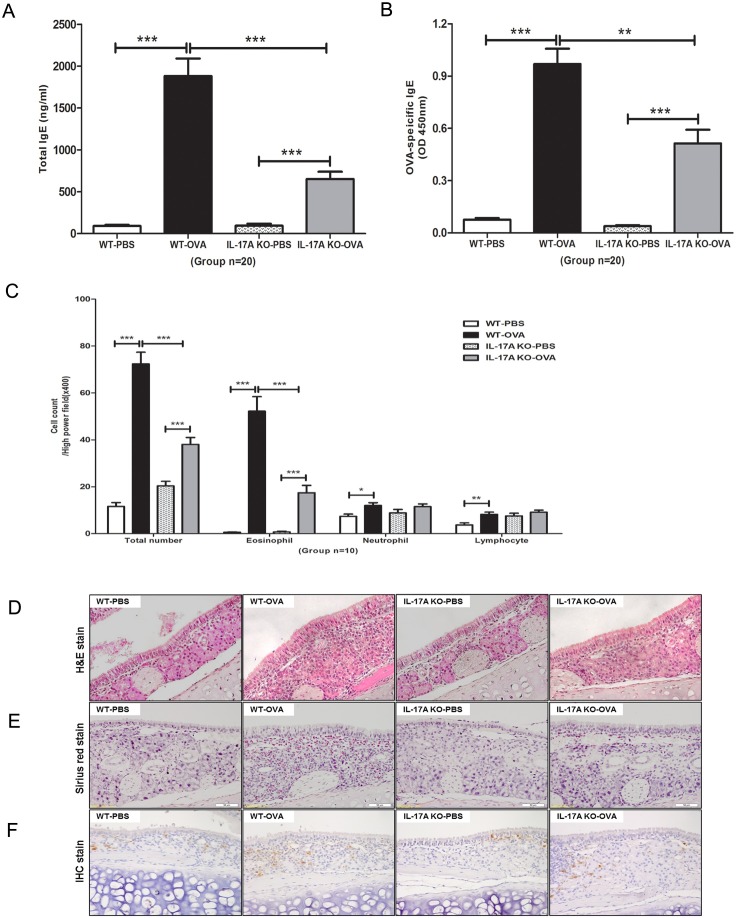
Comparison of serum immunoglobulin E (IgE) levels and eosinophilic infiltration levels.Serum levels of (A) total IgE and (B) OVA-specific IgE were significantly lower in the IL-17A KO-OVA mice than in the WT-OVA mice (n = 20). (C) The total inflammatory cells and eosinophils were significantly reduced (n = 10) in the IL-17A KO-OVA group compared with that in the WT-OVA group. Results are means ± SEM. Histological findings in the nasal mucosa in each group (×400 magnification), with (D) hematoxylin and eosin staining of lymphocytes, (E) Sirius red staining of eosinophils and (F) Immunohistochemistry staining of neutrophils. (*** P < 0.001, ** P < 0.01, * P < 0.05).